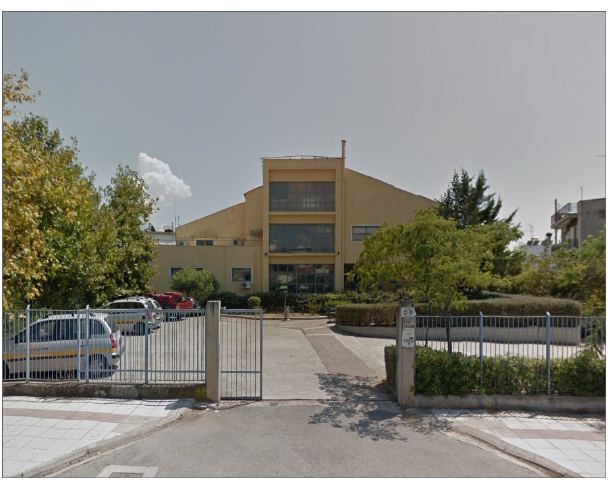
Figure 6: ADEP building, subject of intervention of MESP pilot project in